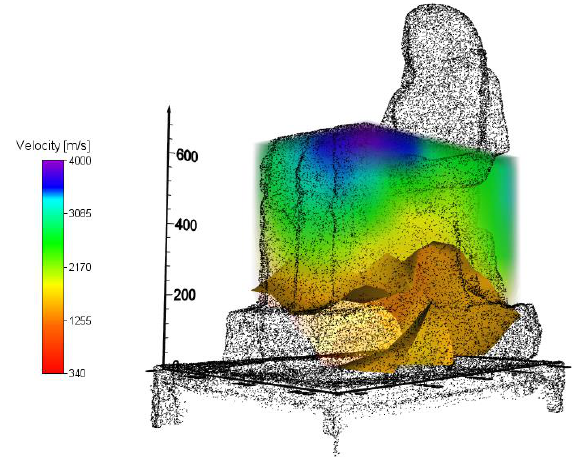
Figure 14. Final model of velocity distribution within the VOI as obtained by the 3D